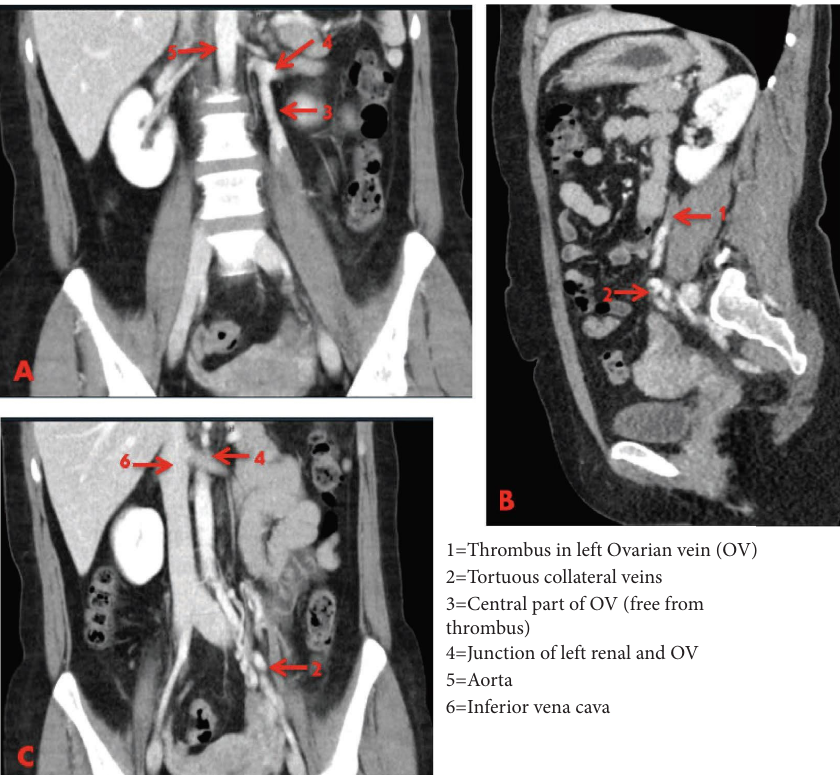
Figure 1: CT abdomen with contrast in venous phase showing thrombosis of the left ovarian vein and tortuous collateral veins. (A, C) coronal and (B) sagittal